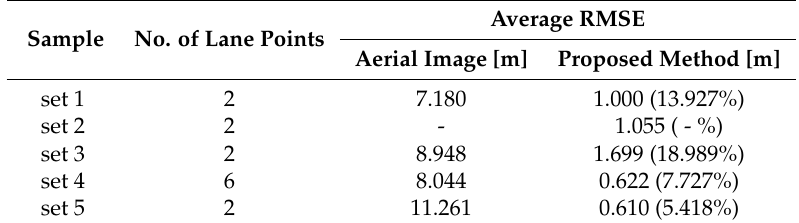
Table 6. Error analysis for the proposed method on road marking. Each dataset has two to six sample points respectively. For set 2, no road marking in the aerial map and excluded in the comparison. The proposed method’s error is also written as a ratio to the aerial image for clear comparison.